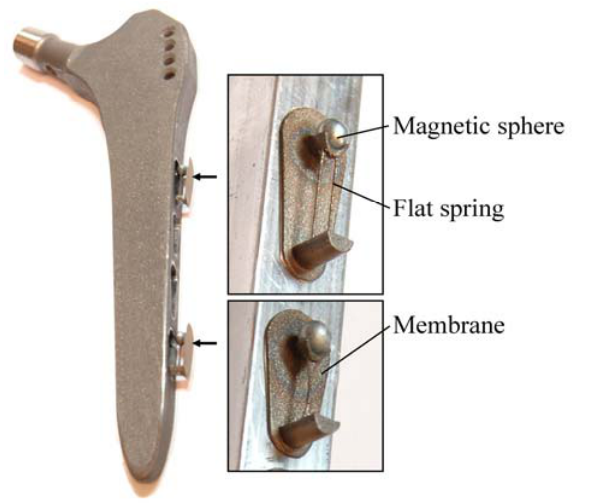
Figure 9. Sensor-equipped demonstrator: Arrangement of the passive sensor array inside a total hip